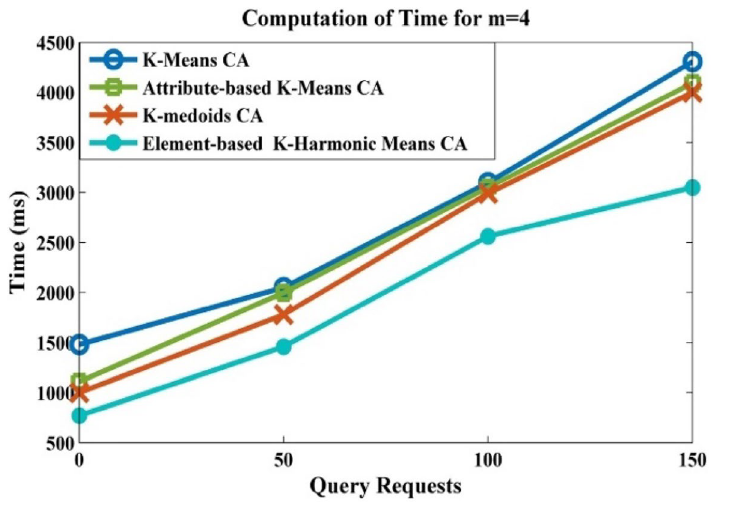
Figure 8. Computation of time for m = 4.